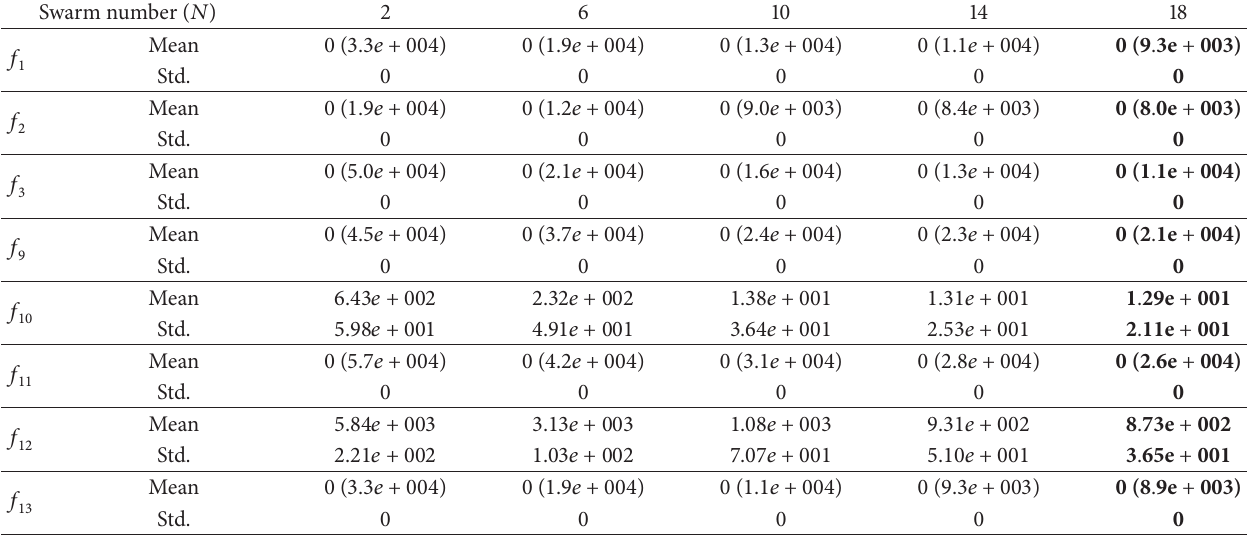
Table 2: HABC’s results on nine test functions with different swarm number N.